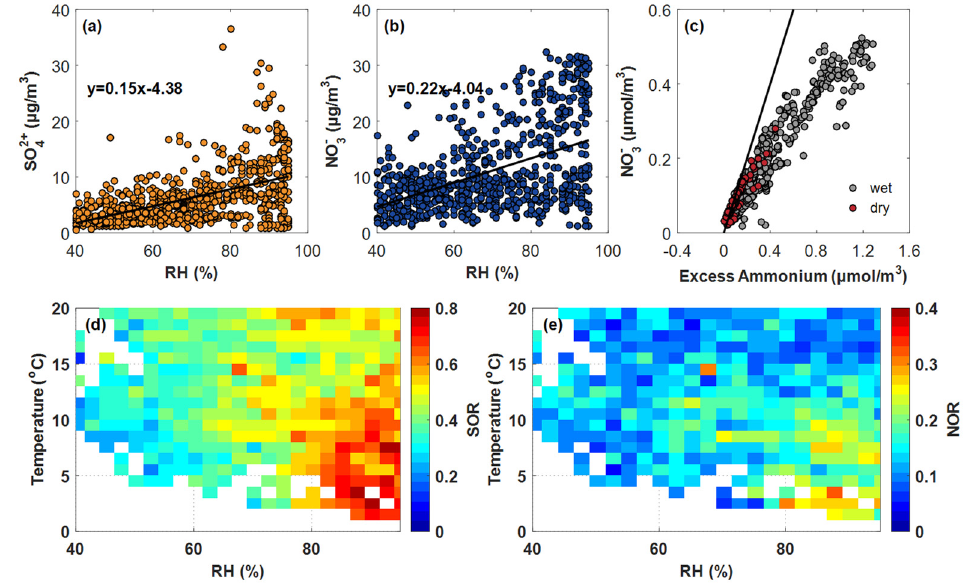
Figure 4. Variation of secondary inorganic salts: ( a ) SO 42 − vs. RH , ( b ) NO 3 − vs. RH , ( c ) NO 3 − vs. excess ammonium, ( d ) sulfur oxidation ratio, and ( e ) nitrogen oxidation ratio. The black line in ( c ) represents the 1:1 reference line.